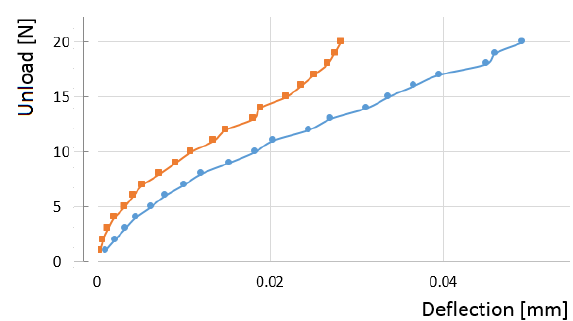
Figure 10: Residual deflection disruption after unloading. Source: Own study.